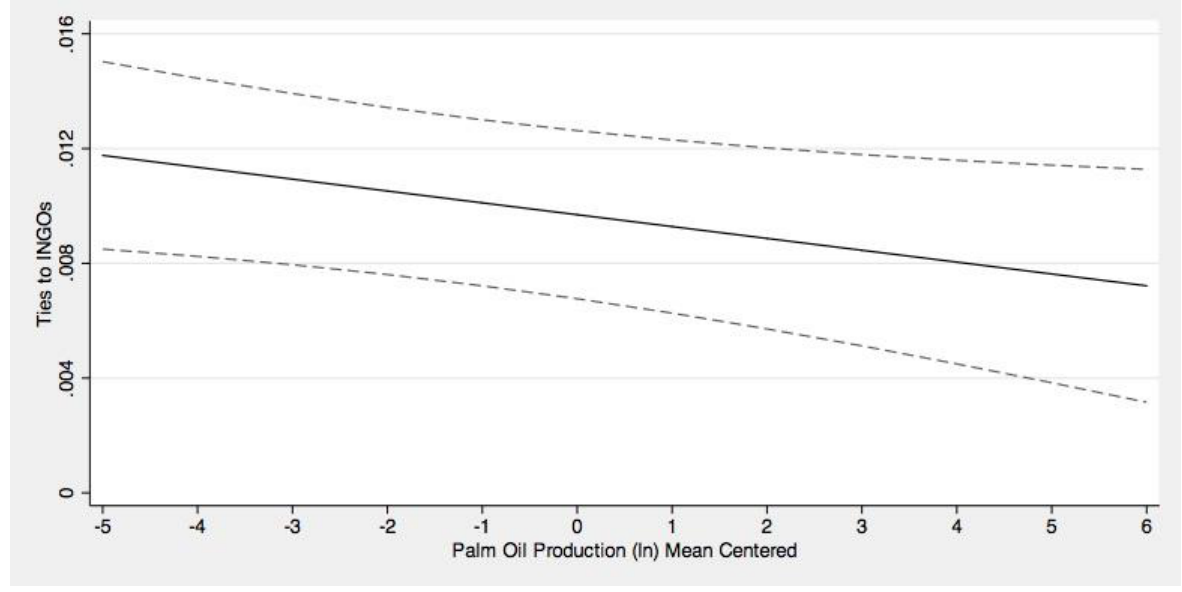
Figure 3. Marginal Effects of Environmentalism by Palm Oil